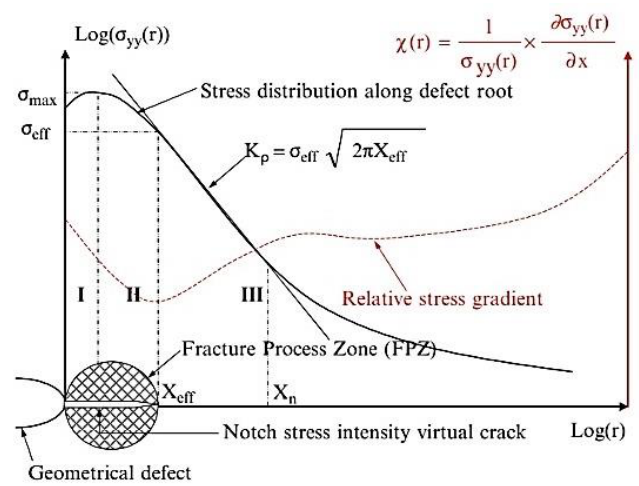
Figure 1. The distribution of elastic−plastic stress along defect [32] .